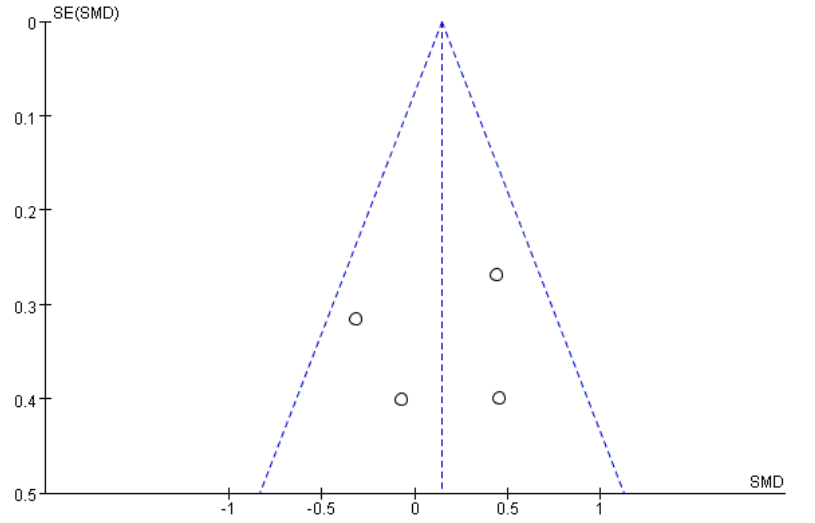
Figure 9. Funnel plot of publication bias for correct rate.